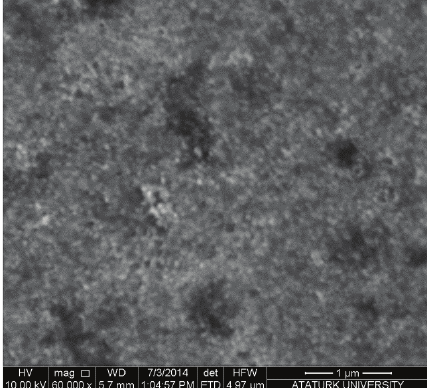
Figure 7: SEM image of the synthesized silver nanoparticles.